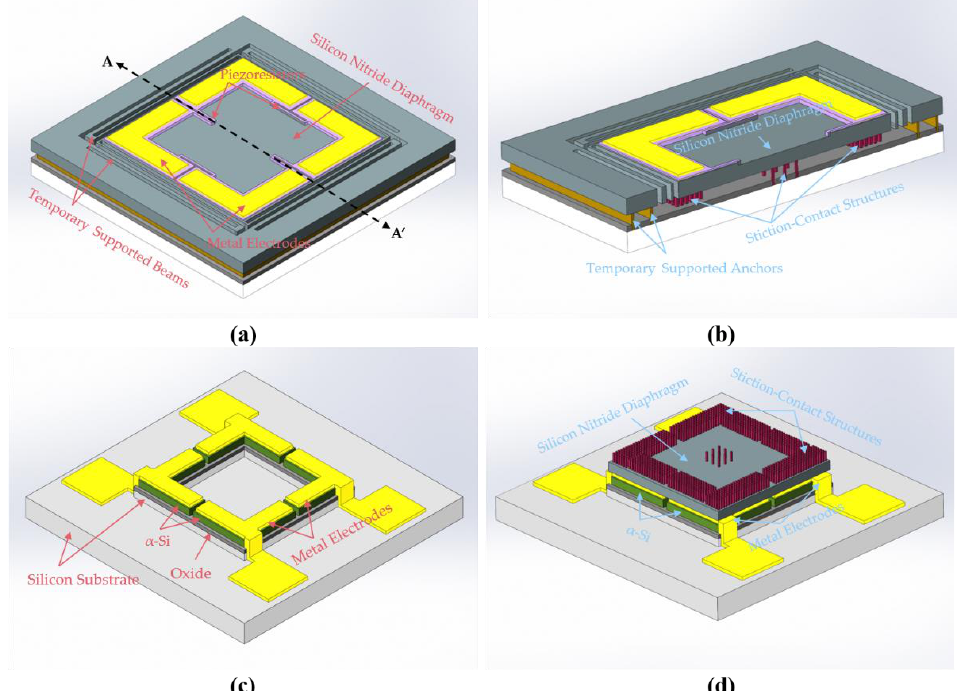
Figure 2. ( a ) Schematic of the tactile sensor; ( b ) Cross-section cut along the line A–A’ in ( a ); ( c ) Schematic of the reroute substrate; ( d ) Schematic of the transferred device.